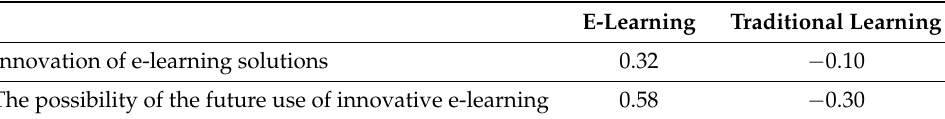
Table 3. Spearman’s correlation between the ease of acquiring content and the innovation of e- learning solutions.